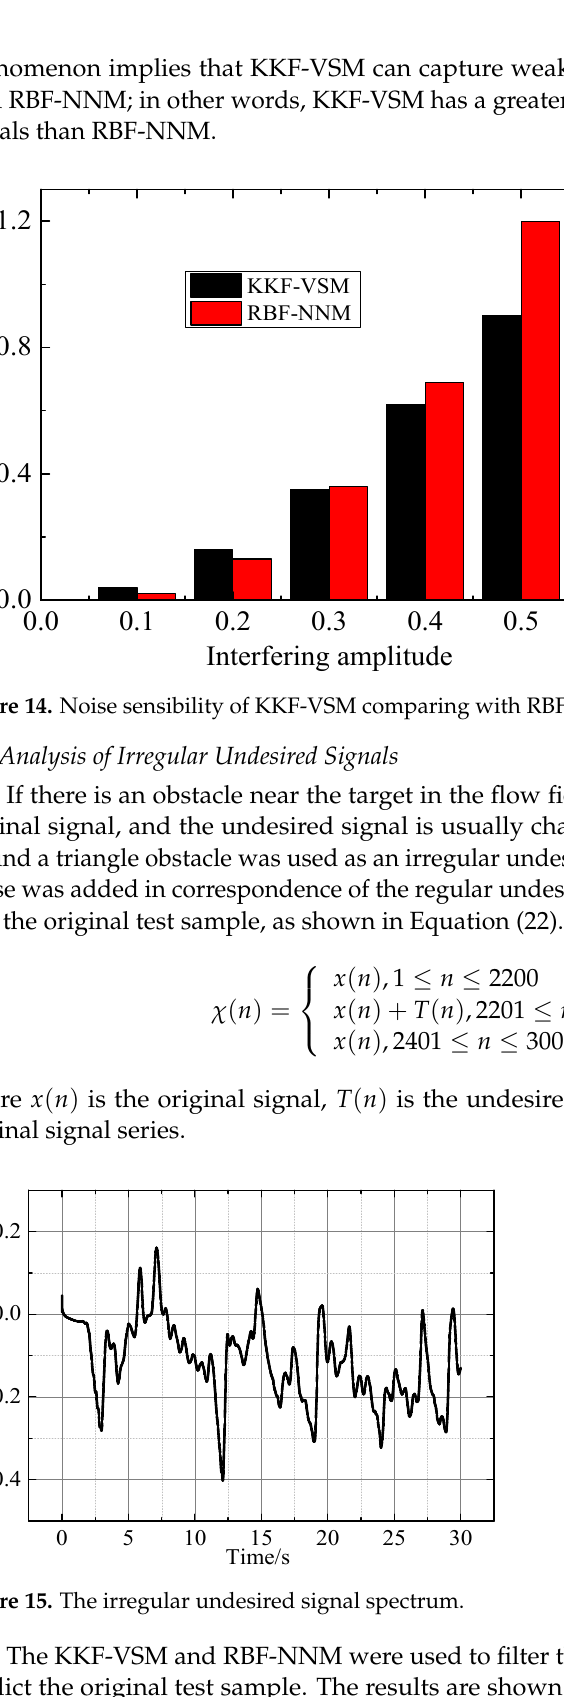
Figure 15. The irregular undesired signal spectrum. The KKF-VSM and RBF-NNM were used to filter the irregular undesired signal and predict the original test sample. The results are shown in Figures 16 and 17. The results indicated that the irregular undesired signal could be filtered, and the change trend of the original samples could be predicted very well by both models. Furthermore, the MSE